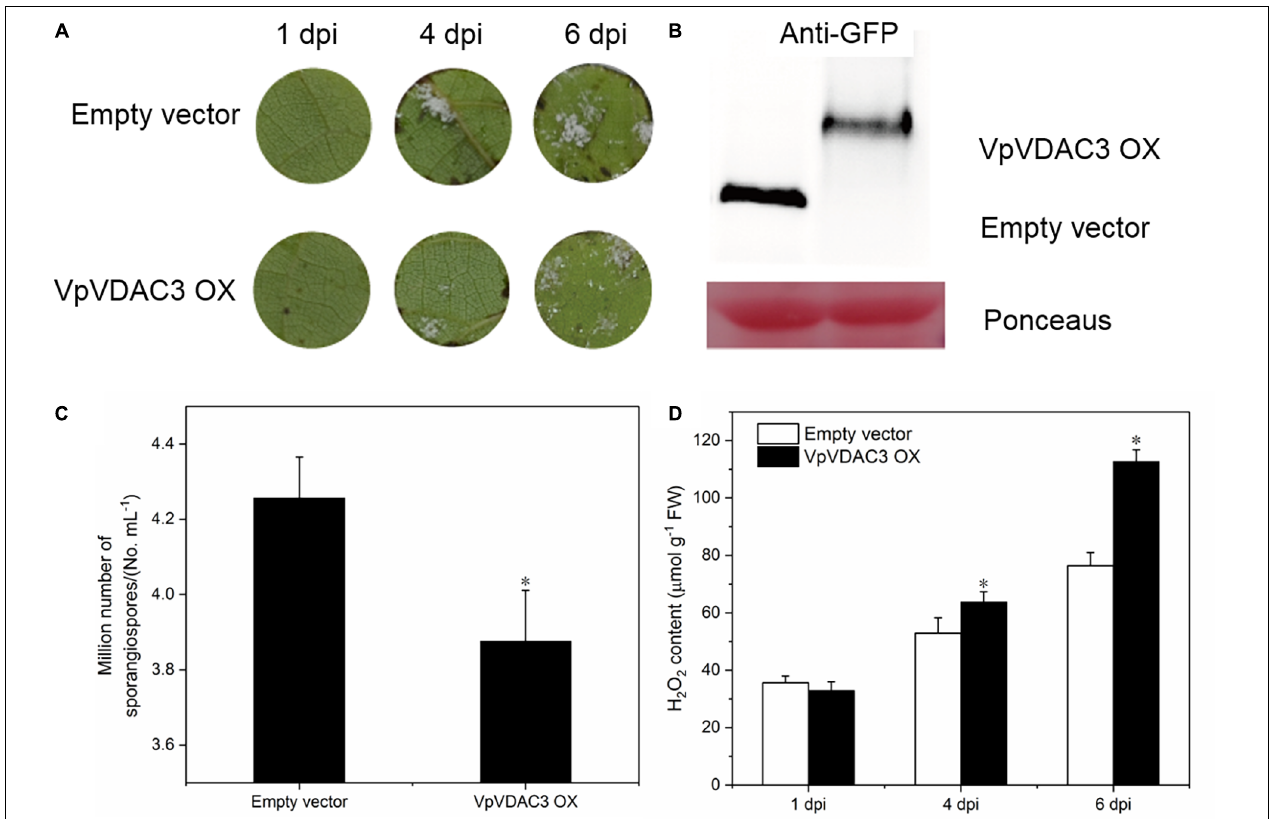
FIGURE 6 | VpVDAC3 enhances H 2 O 2 accumulation during P. viticola infection. (A) p35S: VpVDAC3 and the empty vector transiently transformed in V. vinifera “Thompson Seedless” with P. viticola inoculation. (B) Immunoblot detection of protein expression in transiently transformed grapevine leaves after 6 dpi. (C) Average sporangia density of P. viticola from different genotypes at 6 dpi. (D) H 2 O 2 accumulation. Error bars indicate the SE ( n = 3) from three independent biological replicates. Asterisks indicate significant difference from the control (empty vector) (* P <